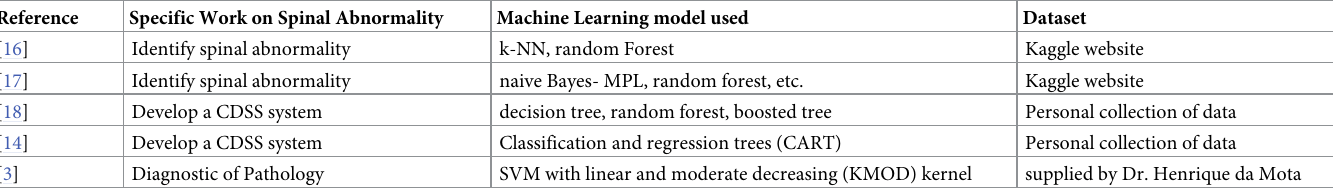
Table 1. Comparison of relevant research